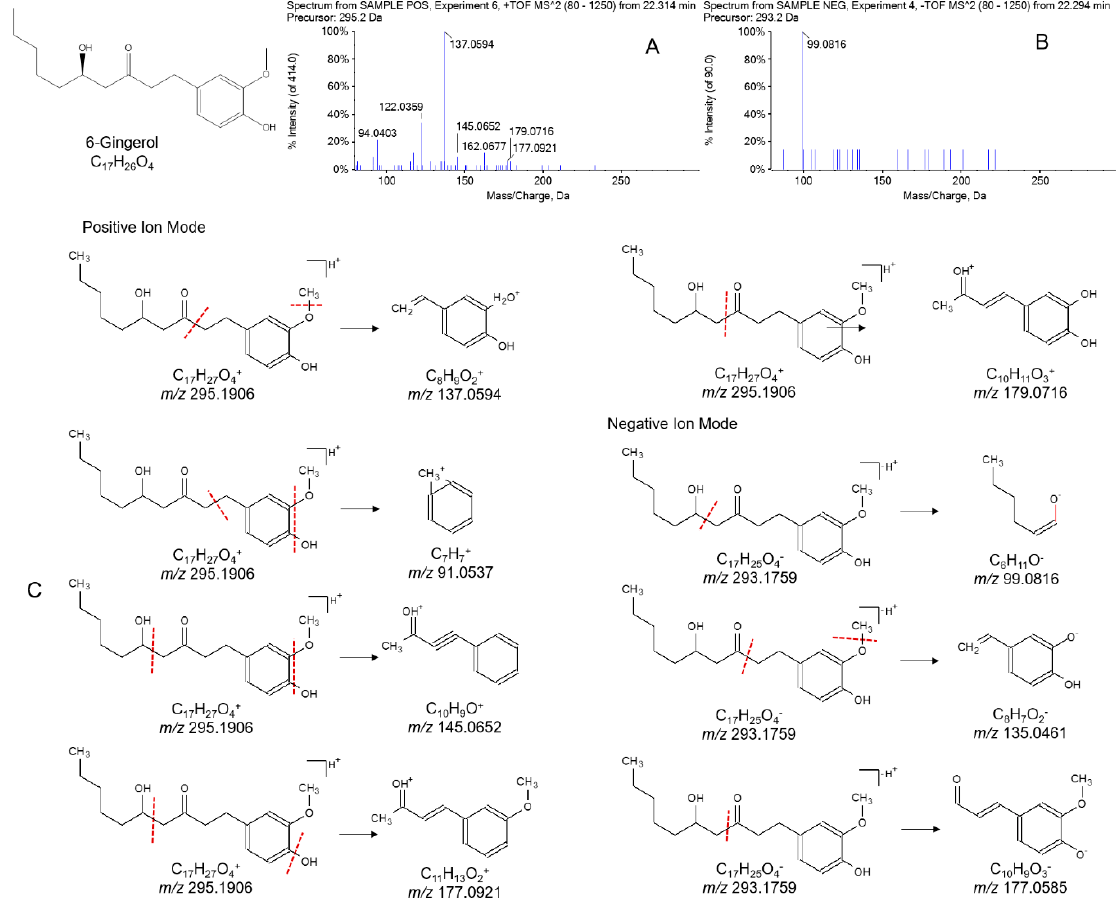
Figure 4. Product ion MS/MS spectrums of 6-gingerol in ( A ) positive and ( B ) negative ion modes and ( C ) fragmentation pathways of 6-gingerol.